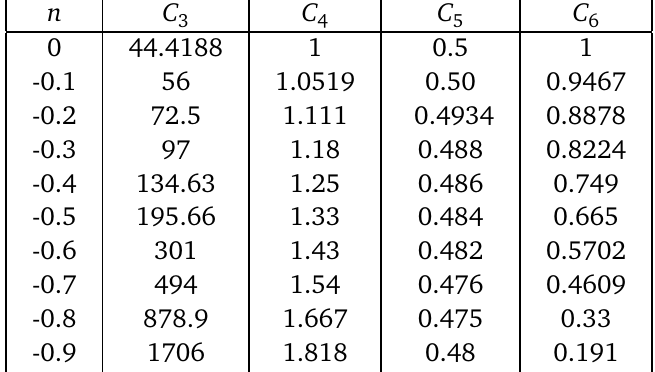
Table 2: The values of the constants of Eq. (31) for various n . Here B chosen in the units of 10 15 G pm − n to obtain C